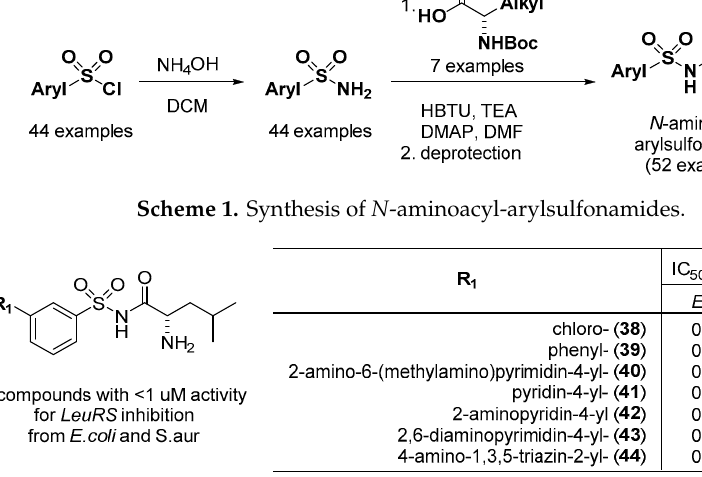
Figure 15. Representative examples of N -aminoacyl-arylsulfonamides and their inhibitory activities against LeuRS from Escherichia coli and Staphylococcus aureus .